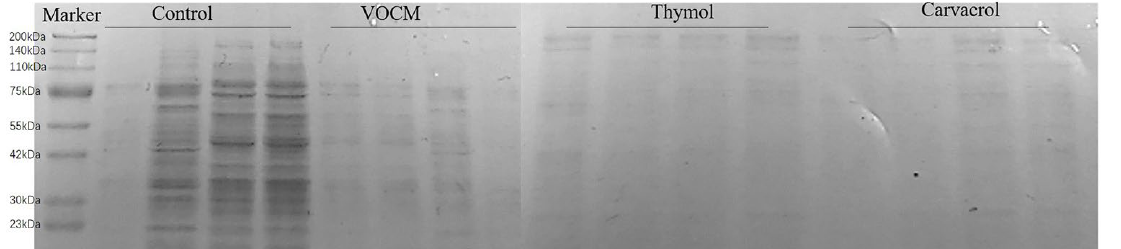
Figure 9. Effect of EOCM, thymol and carvacrol on bacterial protein synthesis. From left to right, they were divided into four groups: control, EOCM, thymol and carvacrol. Each group of protein bands from left to right were incubated with drugs for 3 h, 6 h, 9 h and 12 h, respectively.